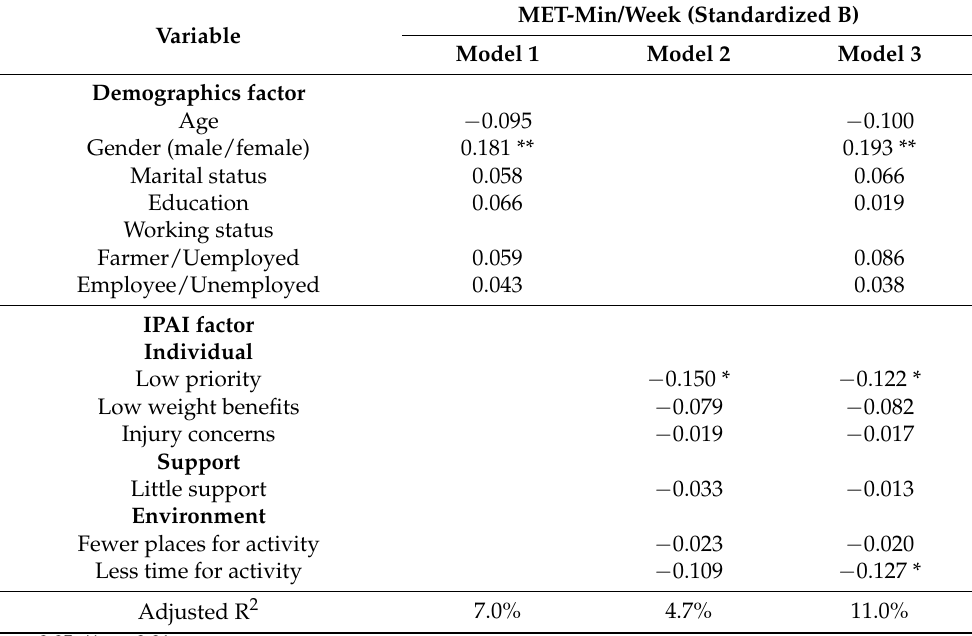
Table 4. Multiple linear regression results for the factors of total MET-min/week using z-scores ( n = 342). MET-Min/Week (Standardized B) Variable Model 1 Model 2 Model